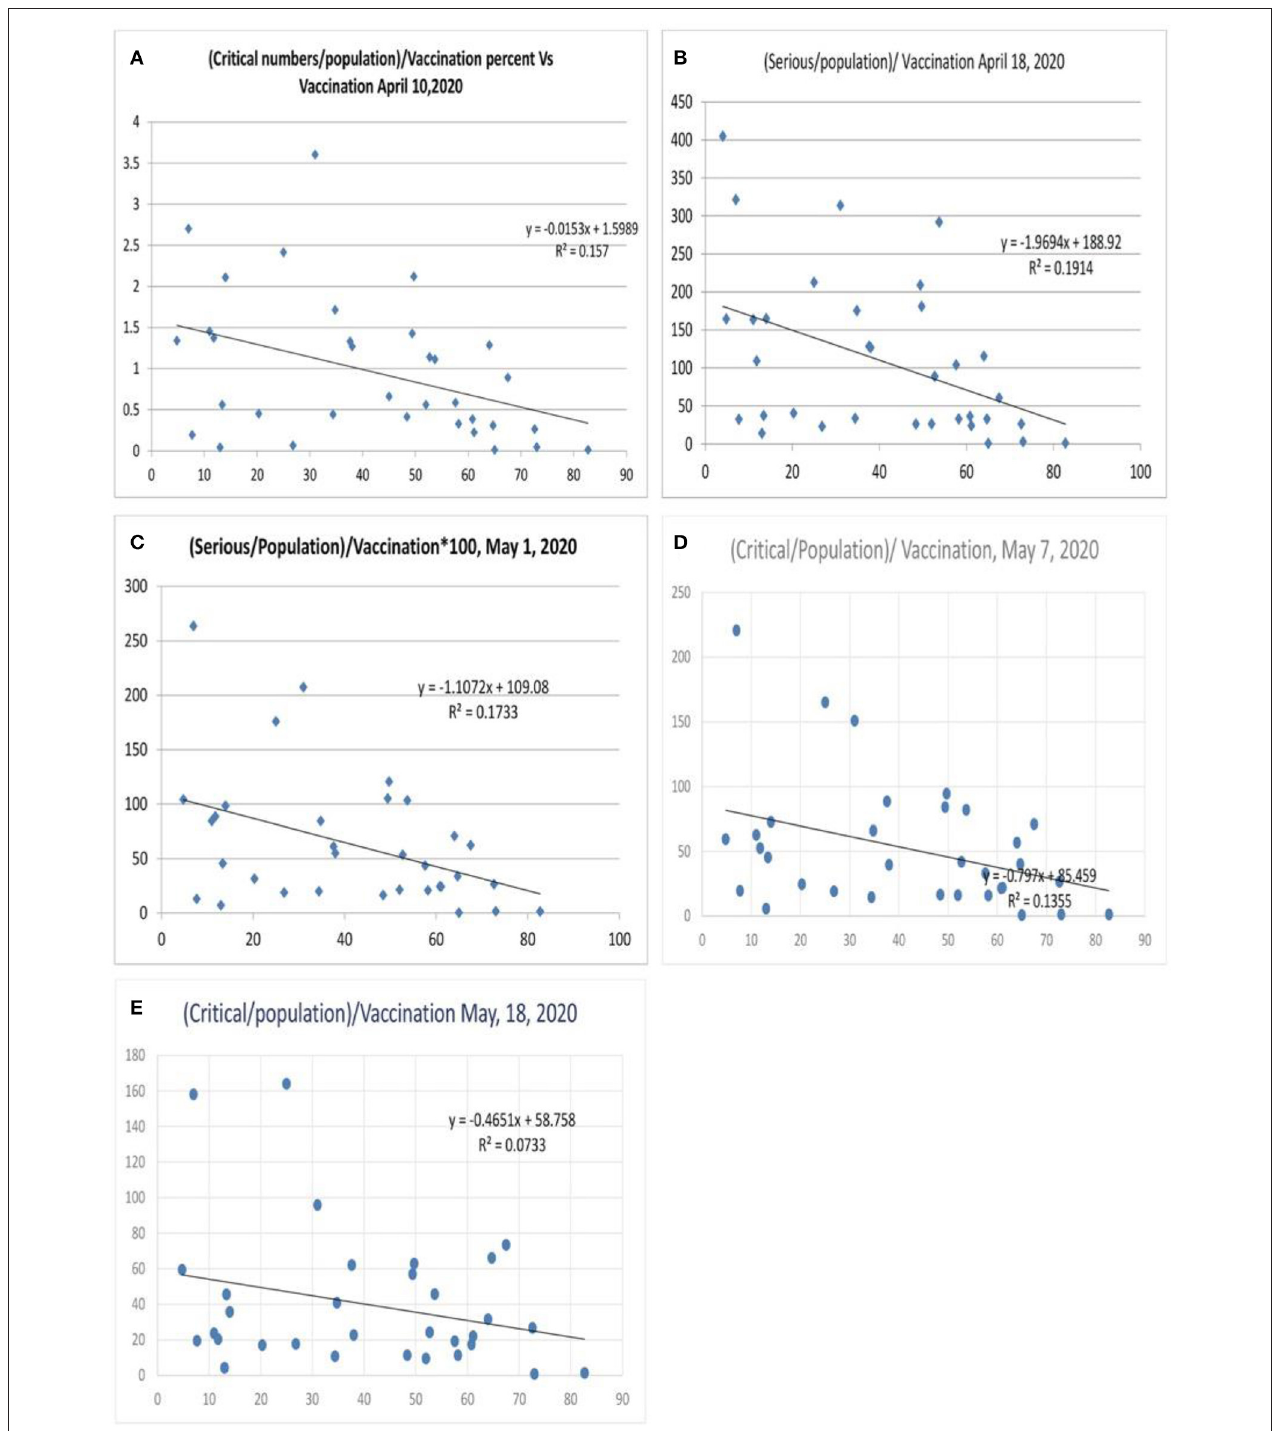
FIGURE 7 | Correlation between influenza vaccination percentage and (critical number/million population)/vaccination percentage [ (A) April 10, 2020, (B) April 18, 2020, (C) May 1, 2020, (D) May 7, 2020, and (E) May 18, 2020].